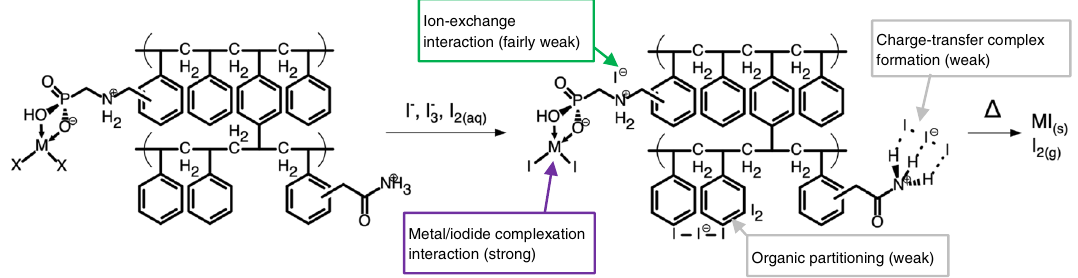
Fig. 4 Illustration of issues of hydrophobic interactions between iodine species and organic adsorbents [23, 24, 29,